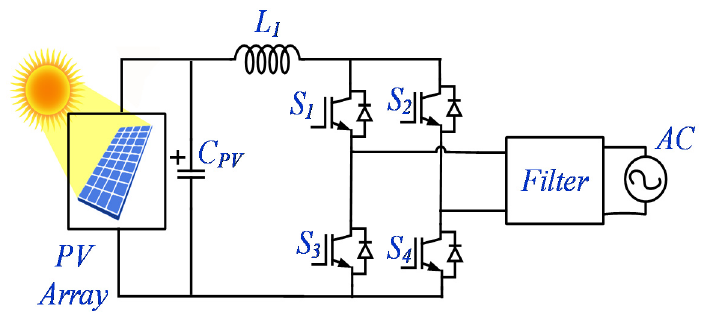
Figure 14. Integrated boost inverter .